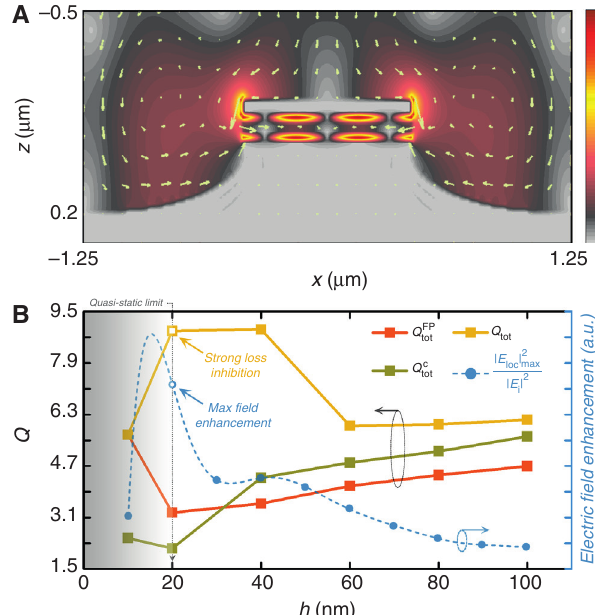
Figure 4: Loss inhibition is ascribed to the energy recycling between FP and cavity modes. (A) Poynting vector diagram of the multilayer trench grating structure with h = 20 nm. The background is the electric field intensity distribution of designed microstructure, and the color bar ranges from 0 to 14. (B) Dependences of the experimental , Q C , Q and Q values of FP on h . The dependence of the electric tot tot tot field enhancement of the grating stripe part on h is also given as reference. The gray area represents the applicable region of the quasi-static